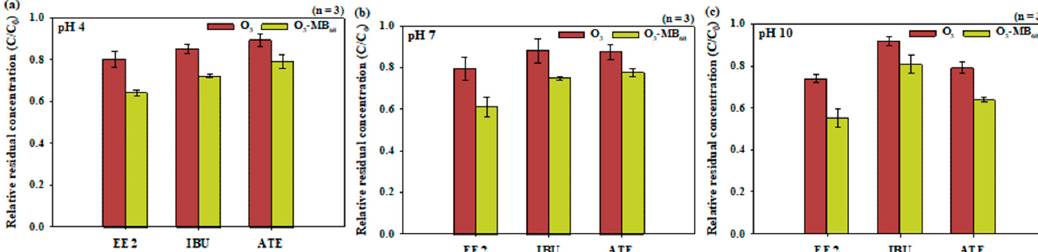
Figure 6. The pH effects on the degradation of the pharmaceutical compounds during the millibubble and microbubble ozonation processes (the initial concentration of each pharmaceutical compound = 2.0 μ M; cavity pump frequency = 60 Hz; temperature = 20 °C , reaction time = 300 seconds; O 3 = millibubble ozonation at 30 Hz; O 3 -MB 60 = microbubble ozonation at 60 Hz): ( a ) pH 4, ( b ) pH 7, and ( c ) pH 10.